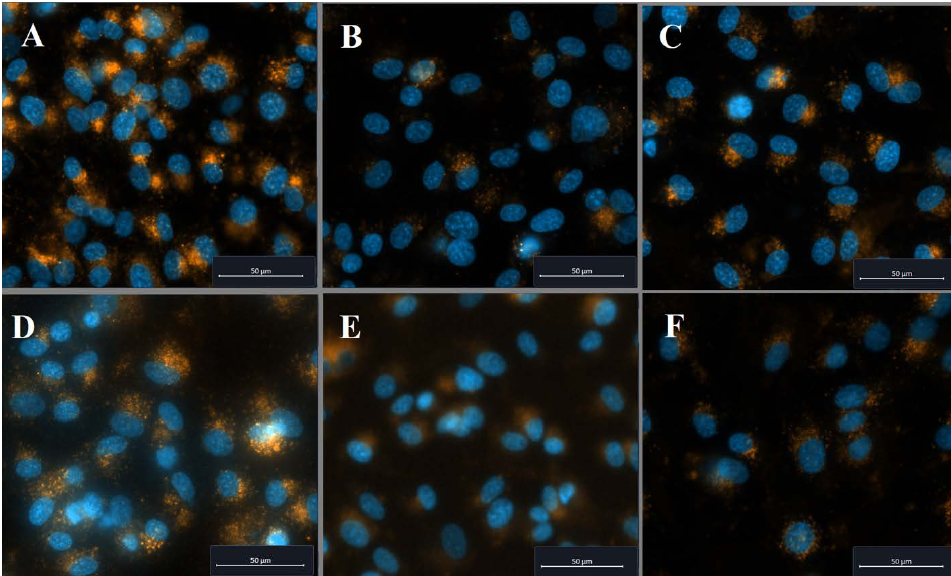
Figure 9. Composite fluorescence micrographs of the U87 cell line after uptake of pure DiI ( G — without inhibitors; H —in the presence of dynasore; I —in the presence of wortmannin) and DiI loaded nanocarriers ( J —without inhibitors; K —in the presence of dynasore; L —in the presence of wortmannin). Cell nuclei are shown in blue as nucleic dye Hoechst 33258 was used. Orange color corresponds to the fluorescence at the DiI emission